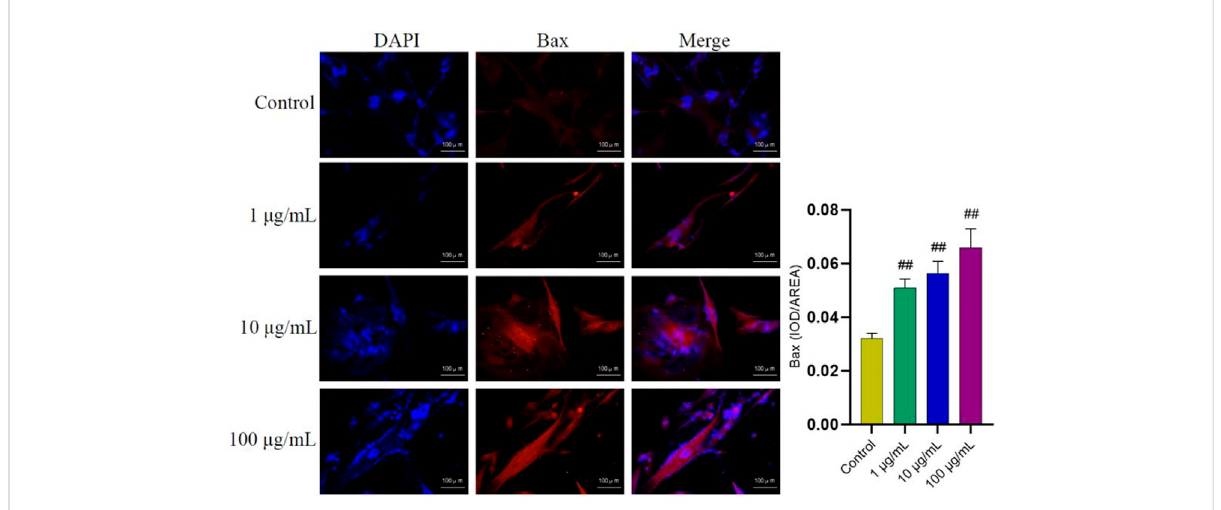
The effects of FTAs on expression of Bax in TNF- α -induced MH7A cells. MH7A cells were exposed to 20 ng/ml TNF- α and intervened by correspondingconcentrations ofFTAsfor 24 h,and then theimmuno fl uorescence ofBax wasobserved byNikon fl uorescence microscope system. The experimental results were recorded as mean ± SD ( n = 3). # p < 0.05, ## p < 0.01 vs. control.